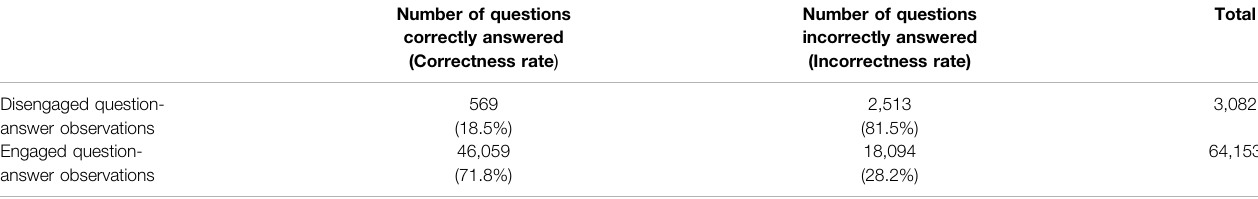
TABLE 2 | Number (proportion) of correctness among disengaged vs. engaged question-answer observations.